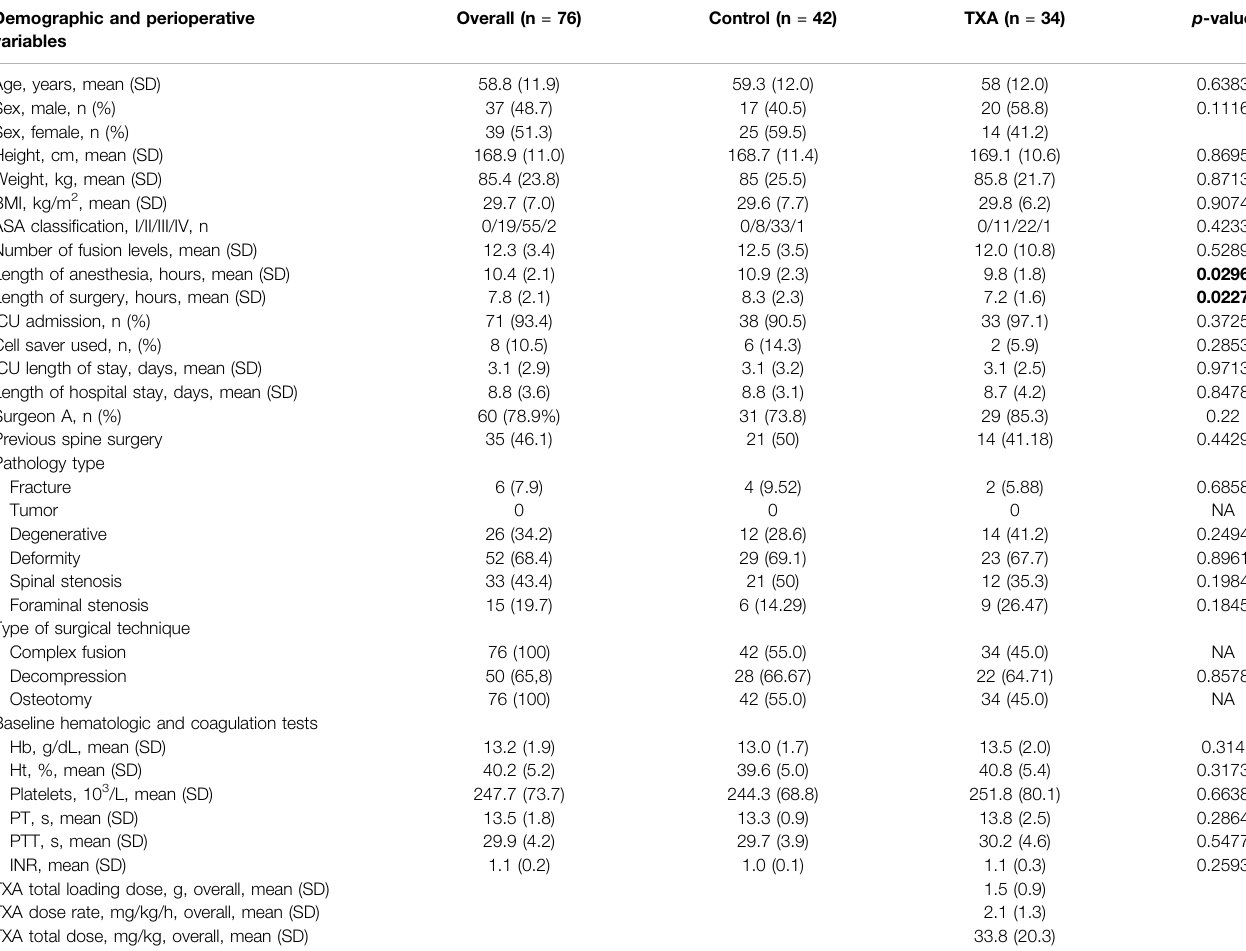
TABLE 1 | Demographic and perioperative variables. Demographic and perioperative variables